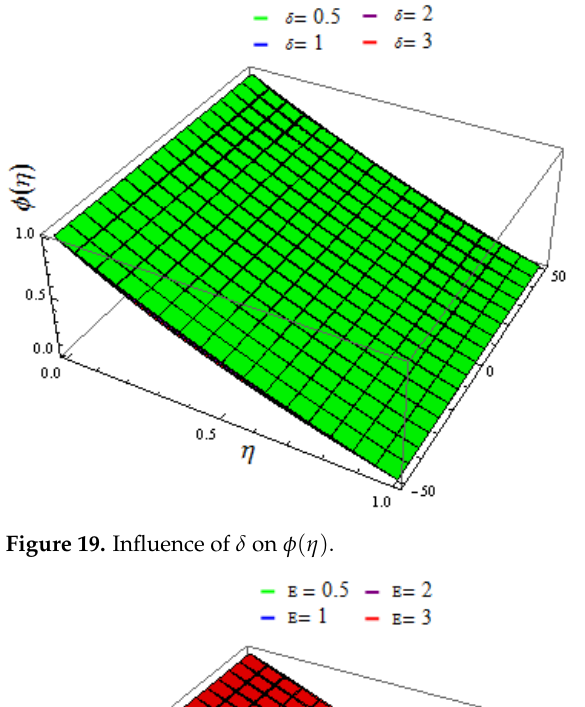
Figure 18. Influence of 𝑁𝑡 on 𝜙(𝜂) .